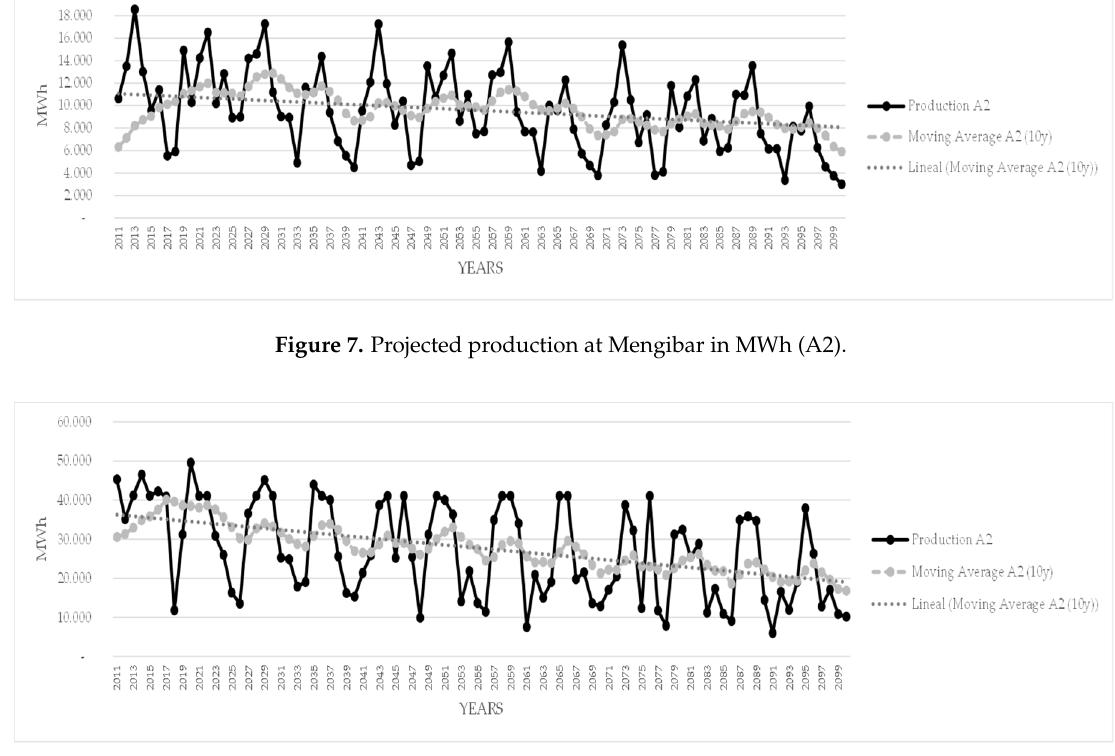
Figure 8. Projected production for Tranco in MWh (A2).